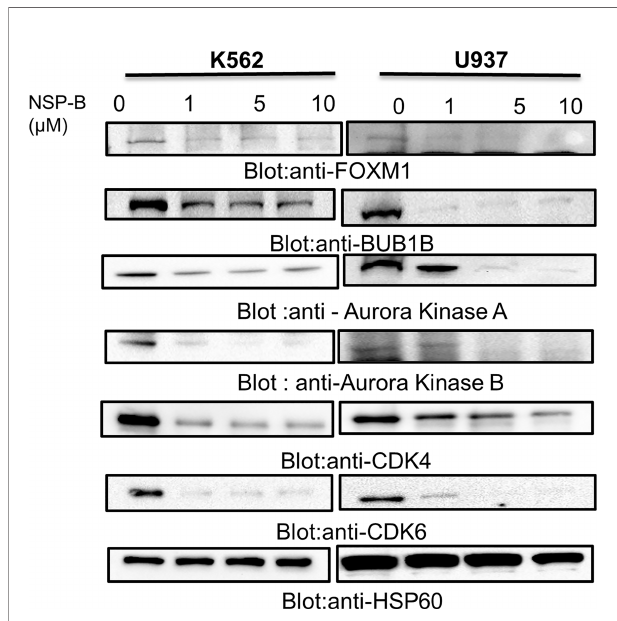
FIGURE 5 | NSP-B mediated downregulation of FOXM1 and its downstream targets in leukemic cells. K562 and U937 cells were treated with increasing doses of NSP-B and equal amount of proteins were immunoblotted against various antibodies such as FOXM1, BUB1B,Aurora Kinases A and B, CDK 4 and 6 and HSP60.NSP-B treatment caused the downregulation of FOXM1 and its downstream targets BUB1B, Aurora Kinases A and B, CDKs 4 and 6.